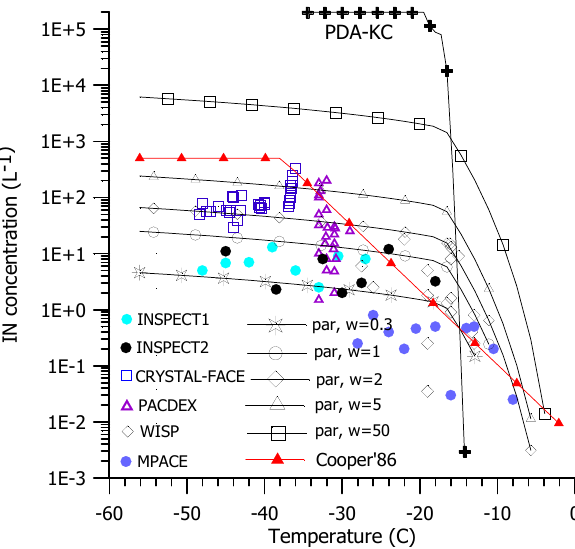
Fig. 4. Temperature dependence of the crystal concentrations N c calculated with w = 1 (solid circles), 2 (diamonds), and 5 cm s -1 (crosses), and 50 cm s -1 (green square). Each solid symbol corresponds to a final N i after a single run of the parcel model with KC (2000, 2004, 2005) heterogeneous DF ice nucleation scheme. The values of the contact parameter m is = 0.52 = const along the continuous lines, the other values of m is are shown near the points that are outside the lines; the symbol “ α ” denotes the runs with α = 2 × 10 -5 . Red symbols denote CCN freezing at δ w > 0 in the presence of drops in a mixed cloud, mostly at T c > -20 ºC, although mixed phase can be below -20ºC and down to -30 ºC with lower m is = 0.12-0.30. Blue symbols denote ice nucleation at δ w < 0 in a crystalline cloud. The solid lines with the open symbols plotted for w = 0.3, 1, 2, 3, 5, and 50 cm s -1 are parameterizations from KC05 of the simulation data as described in the text. These lines are compared with Cooper’s (1986) parameterization (triangles). These fits might be used as a simple parameterization of the average data in Figure in cloud models and GCMs.